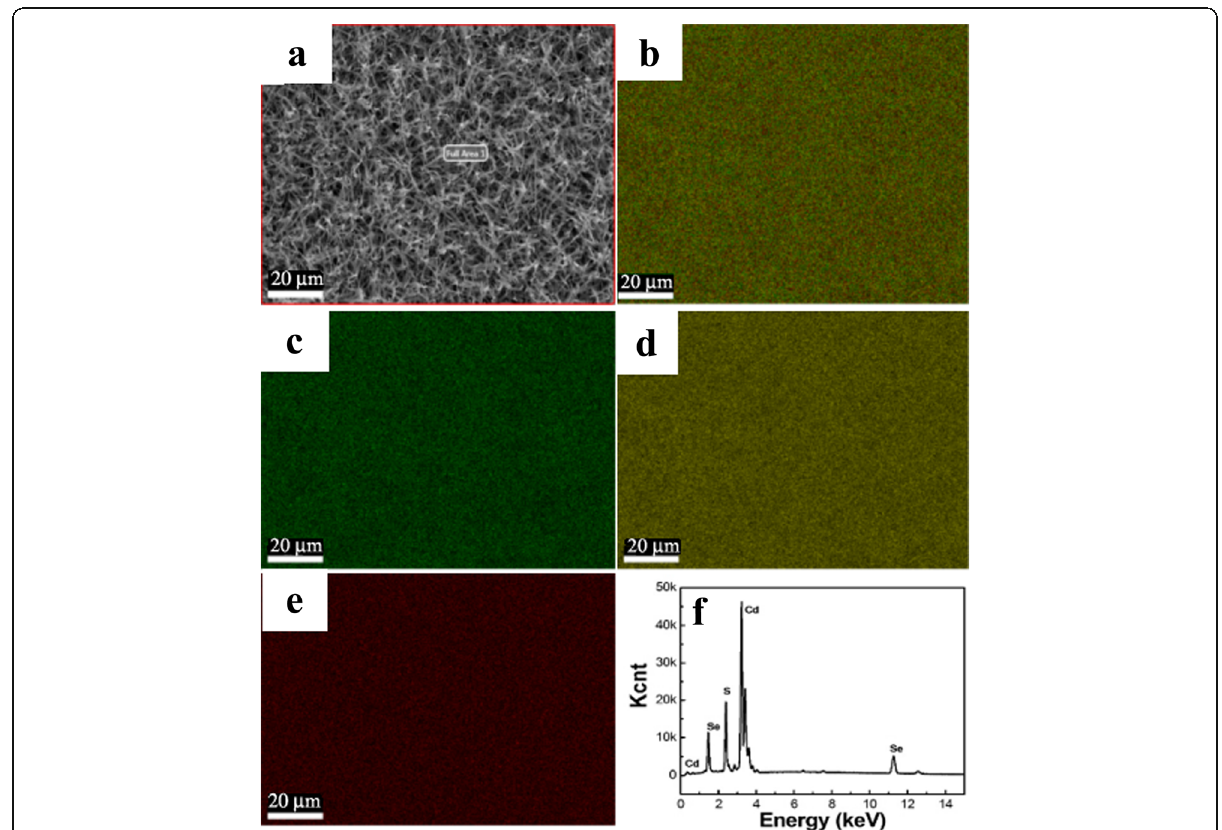
Fig. 3 SEM image and elemental mappings of CdSSe NBs. a SEM. b – e Cd, S, and Se mappings, respectively. f